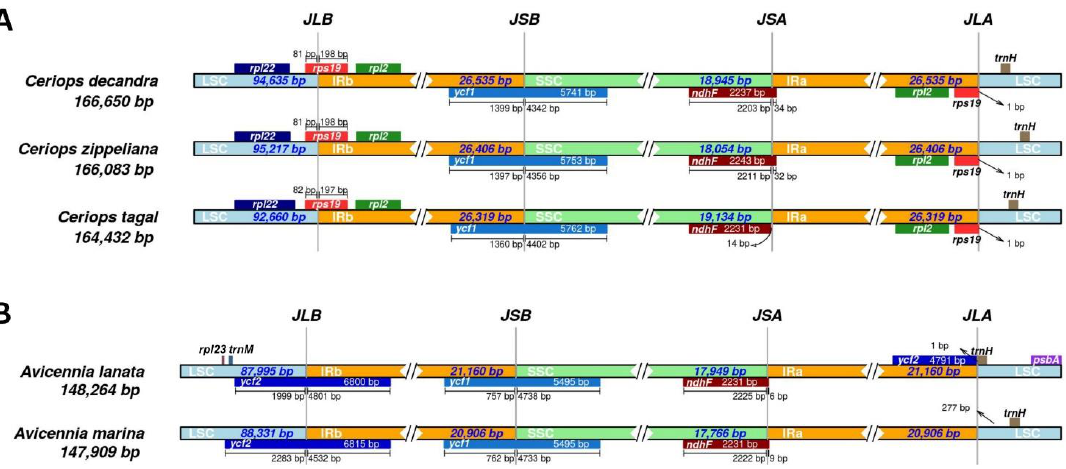
Figure 3. Comparison of IR boundaries of chloroplast genomes. ( A ) IR boundaries among three Ceriops species. ( B ) IR boundaries among two Avicennia species.